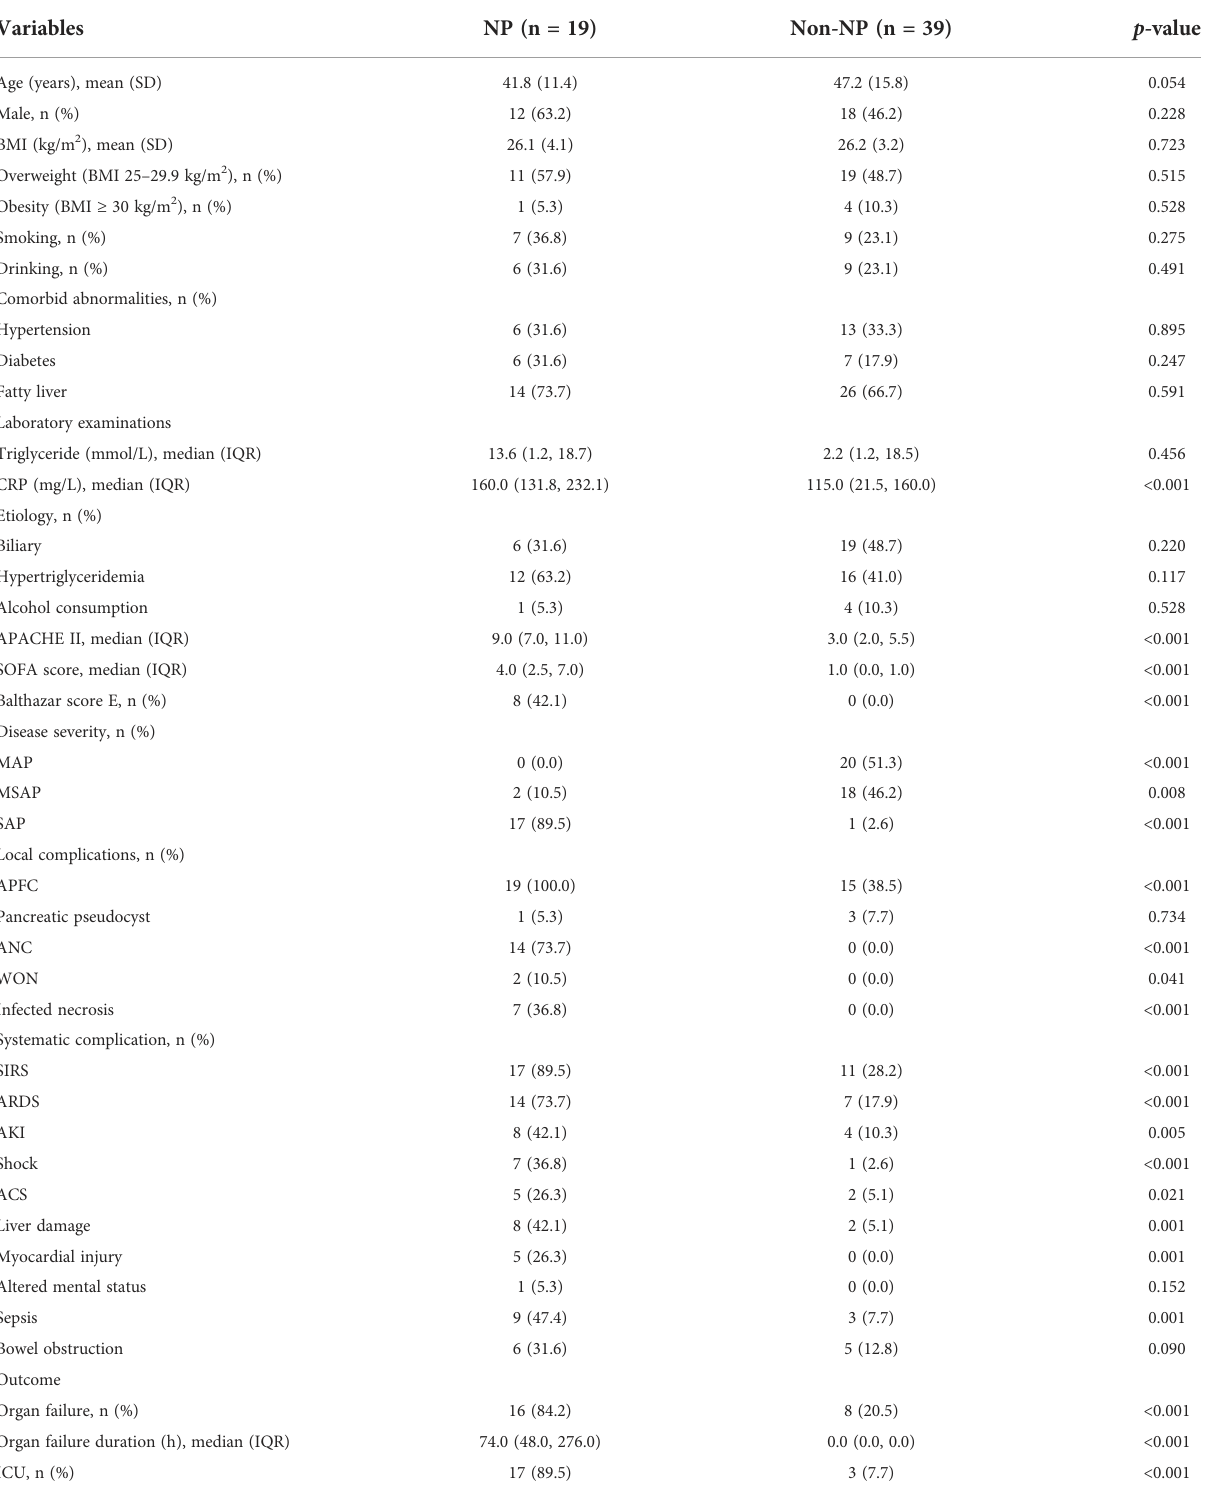
TABLE 1 Demographic and clinical characteristics of two